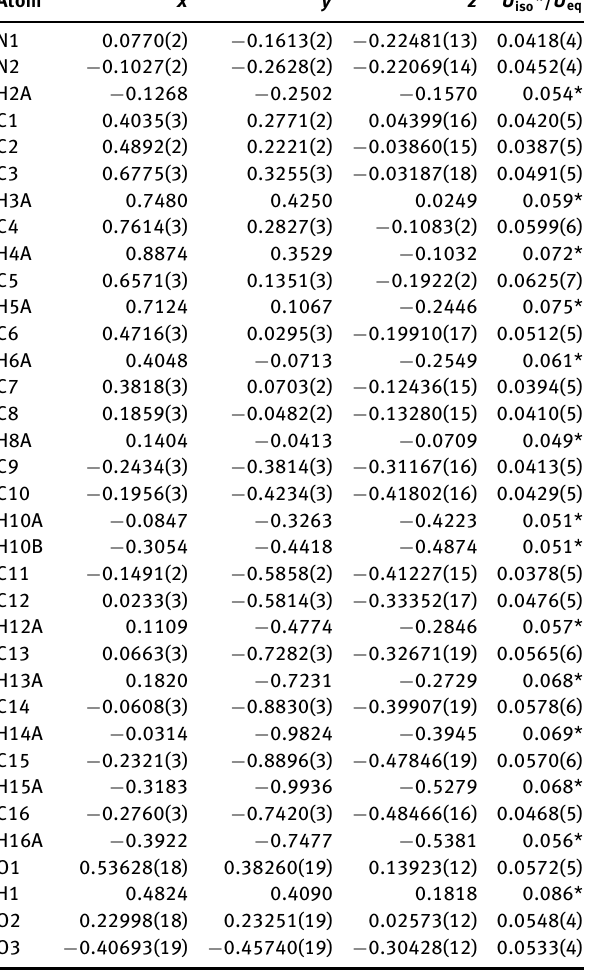
Table 2: Fractional atomic coordinates and isotropic or equivalent isotropic displacement parameters (Å 2